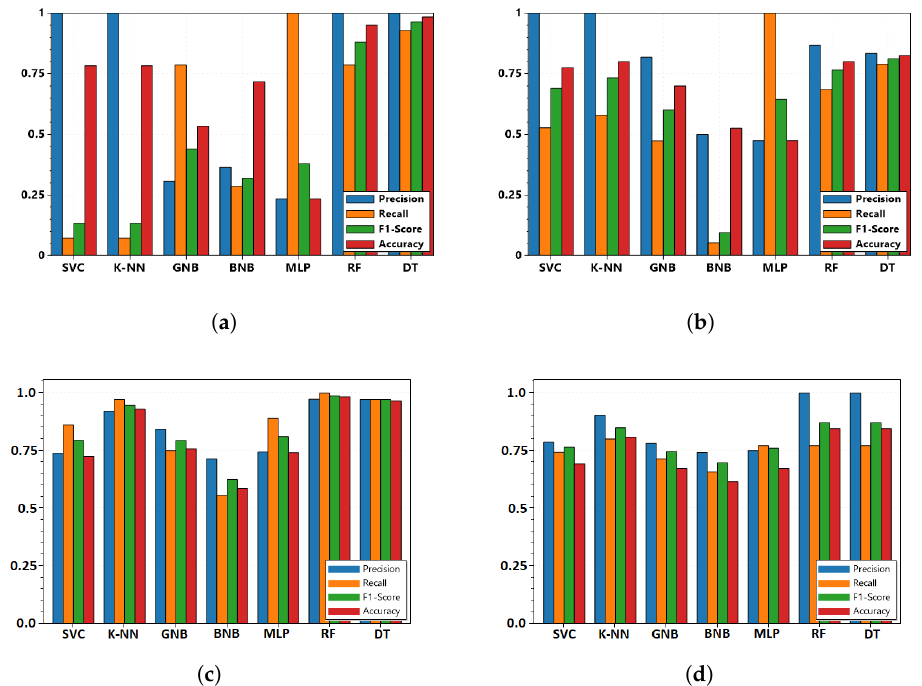
Figure 7. Precision, recall, F1 score, and accuracy obtained based on the pignistic score from disjunctive-based DS fusion by location and domain performed from probability scores from different classifiers with pure cyber and pure physical features combined using FLD architecture in Figure 3 for ( a ) UC1; ( b ) UC2; ( c ) UC3; ( d )